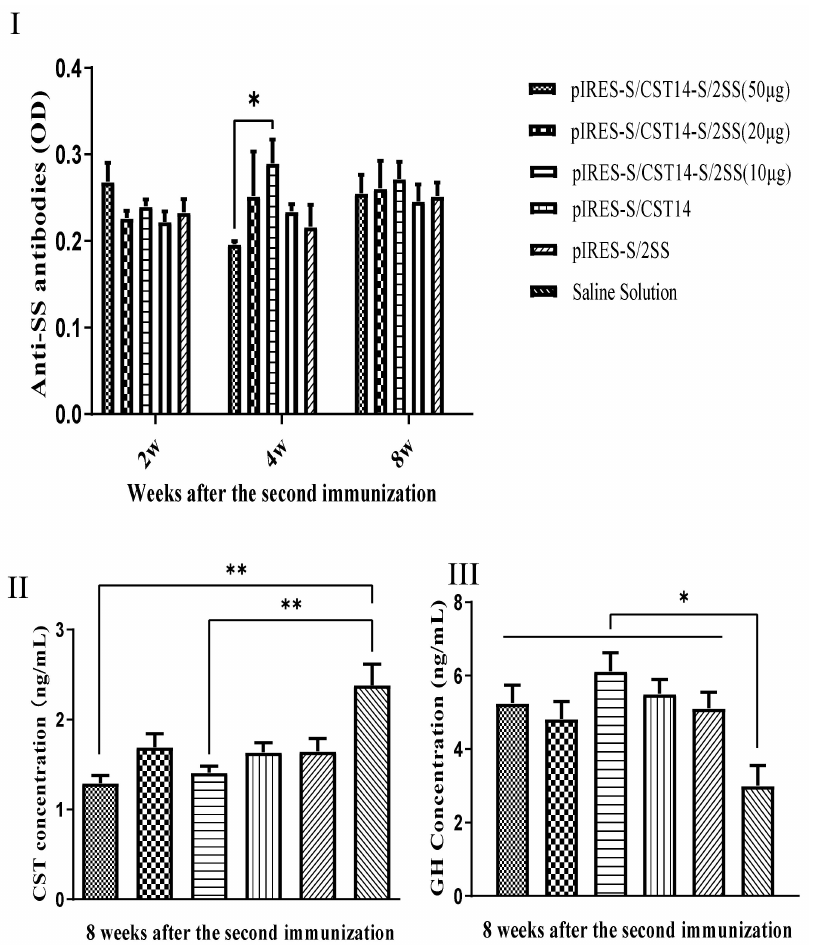
Figure 4. ( I ) The detection of anti-somatostatin antibodies in mice immunization with 100 µ L of pIRES-S/CST14 -S/2SS (50 µ g), pIRES-S/CST14 -S/2SS (20 µ g), pIRES-S/CST14-S/2SS (10 µ g), pIRES-S/CST14 (20 µ g), pIRES-S/2SS (20 µ g), and saline solution at 2, 4, and 8 weeks after a booster immunization. ( II , III ) Cortistatin and growth hormone concentration of all groups were measured at 8 weeks after the second vaccination. The results are expressed as the mean ± SEM. * means significant differences at p < 0.05, and ** means significant differences at p <